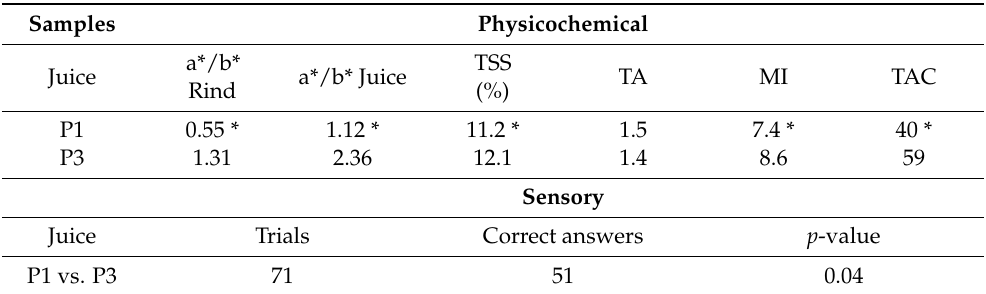
Table 1. Physicochemical characteristics of juice samples with markedly different rind pigmentations (Orchard 2, samples P1—slight rind pigmentation and P3—intense rind pigmentation) and results from the triangular test performed by consumers. TA is expressed as g citric acid/100 mL and TAC as mg/L. For each parameter, * indicates significant differences between the two different juice